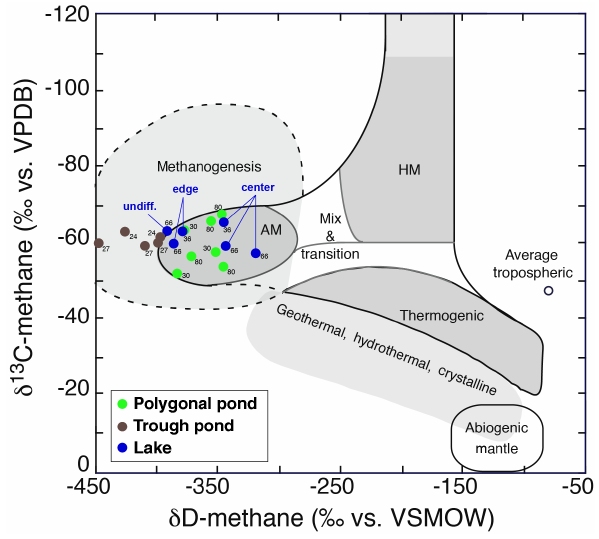
Figure 7. Carbon ( δ 13 ) and hydrogen ( δ D) isotope composi- tion of the methane emitted through ebullition by the sampled ponds and lakes, after Whiticar et al. (1986). AM = acetoclastic methanogenesis; HM = hydrogenotrophic methanogenesis; un- diff. = undifferentiated lake sample location (edge vs.